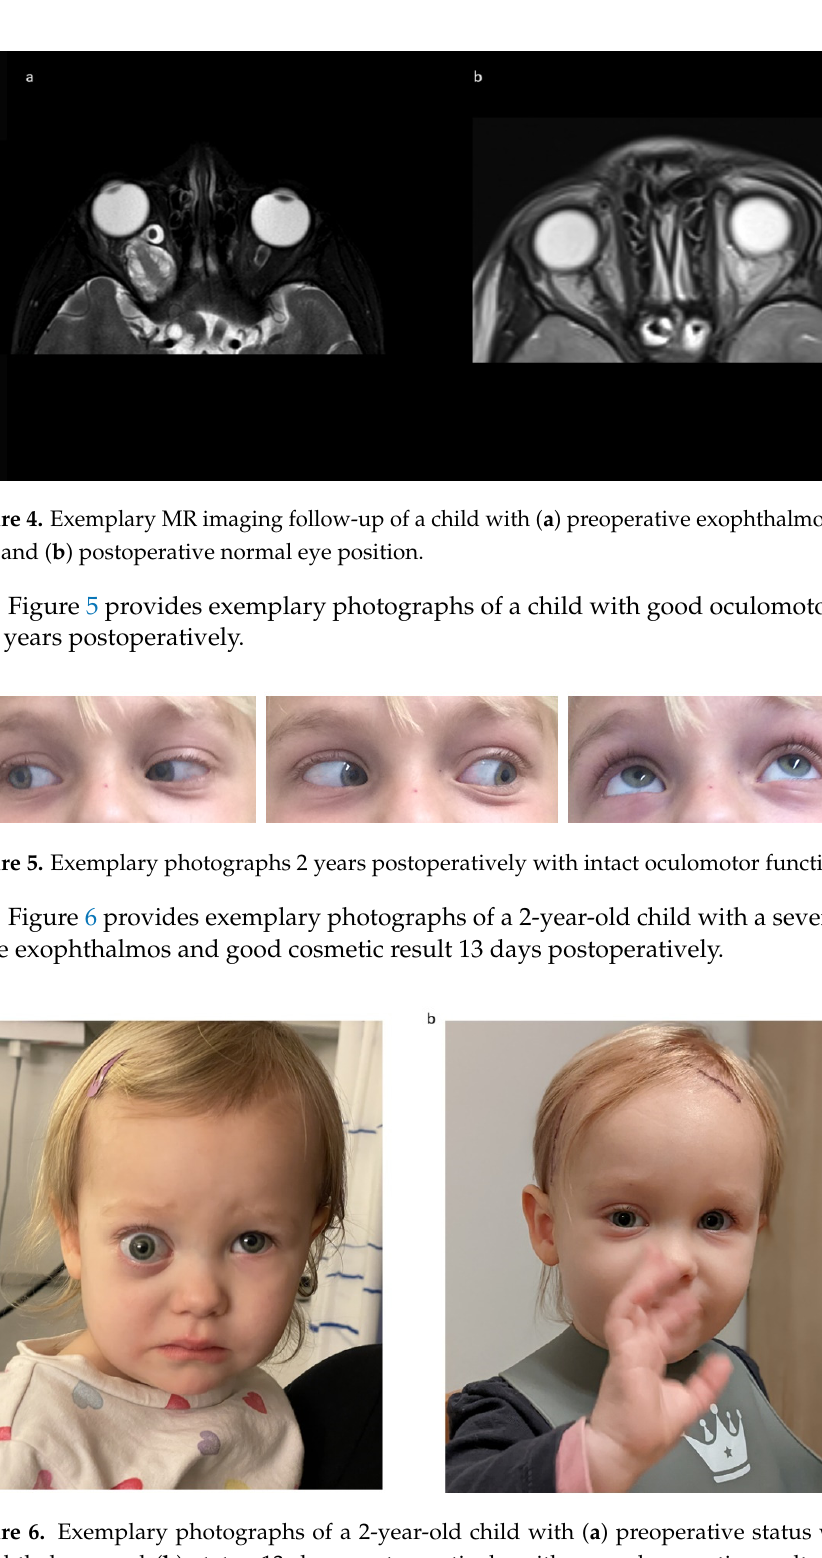
Figure 6. Exemplary photographs of a 2 ‐ year ‐ old child with ( a ) preoperative status with severe exophthalmos and ( b ) status 13 days postoperatively with a good cosmetic result and normal eye po ‐ sition.